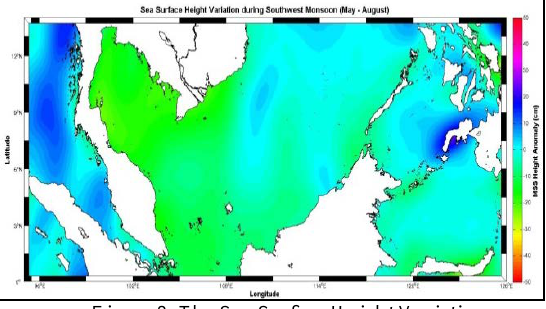
Figure 8. The Sea Surface Height Variation during Southwest Monsoon